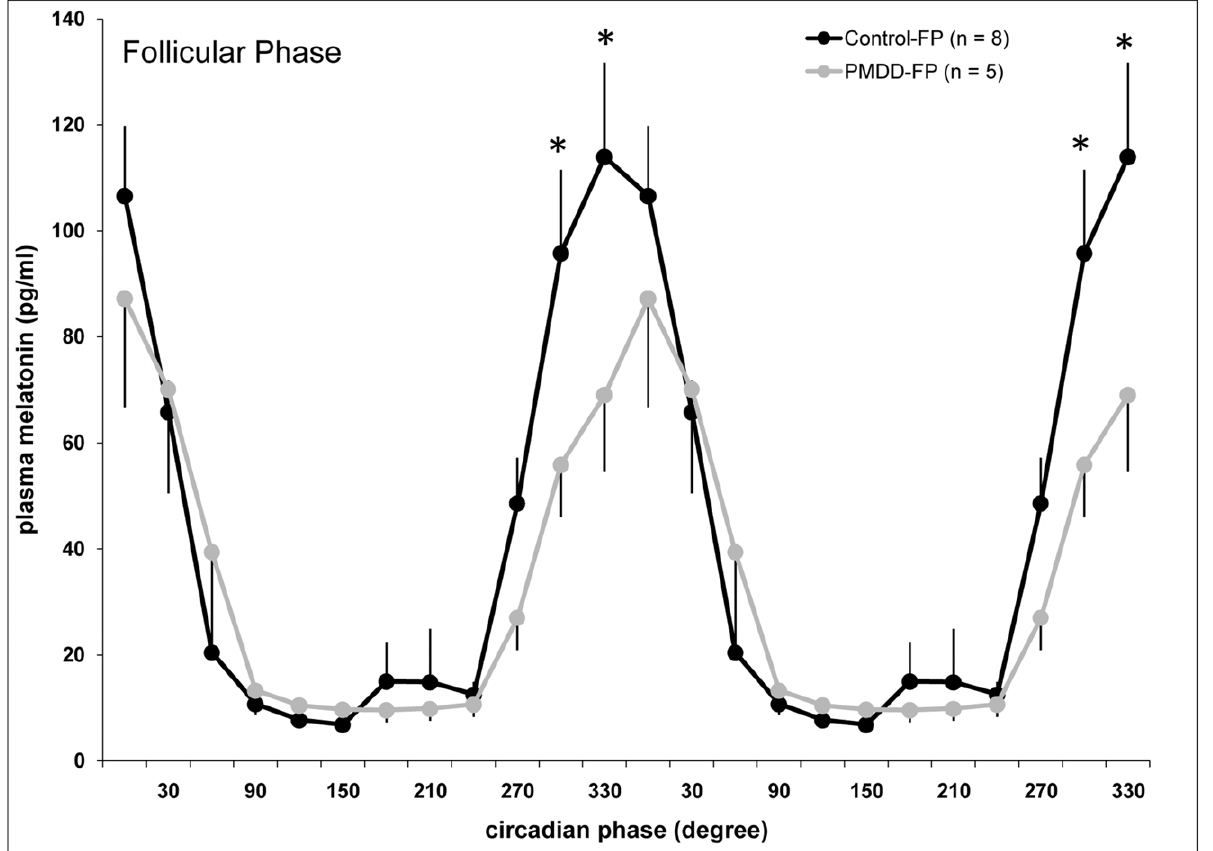
Figure 2. Circadian variation of plasma melatonin during the follicular phase in PMDD women and an expanded group of controls. { * indicates significant differences between controls and PMDD women (P , .05). Data are double-plotted for illustration purposes. Values are mean 6